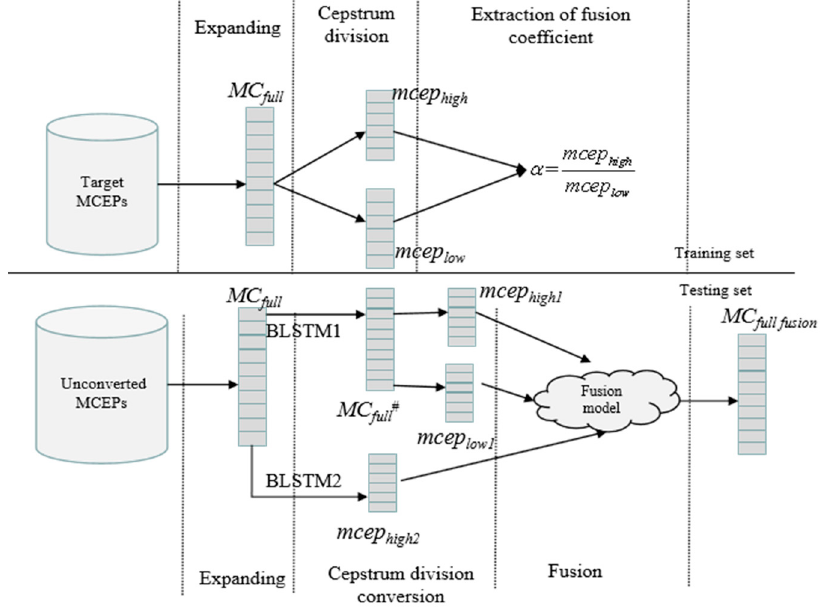
Figure 3. The diagram of the cepstrum-weighted fusion process, where the MC represents the full band MCEPs in different cases.